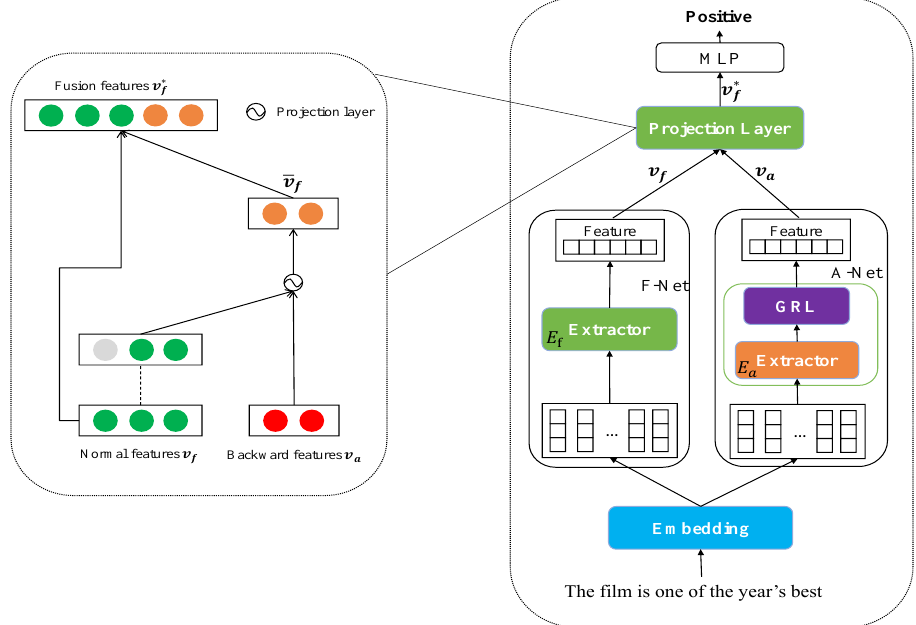
Figure 1. The architecture of FA-Net. The right structure shows the detail of the projection layer. The left one displays the whole network as part of the right boxed figure. Each component is the same except for the extractor of F-Net and A-Net. Note that the “Embedding” concludes with the blue box, but it is not the embedding layer. Rather, it is an abstract layer. The outputs of “Embedding” may be produced by the embedding layer or by one of the transformer encoder